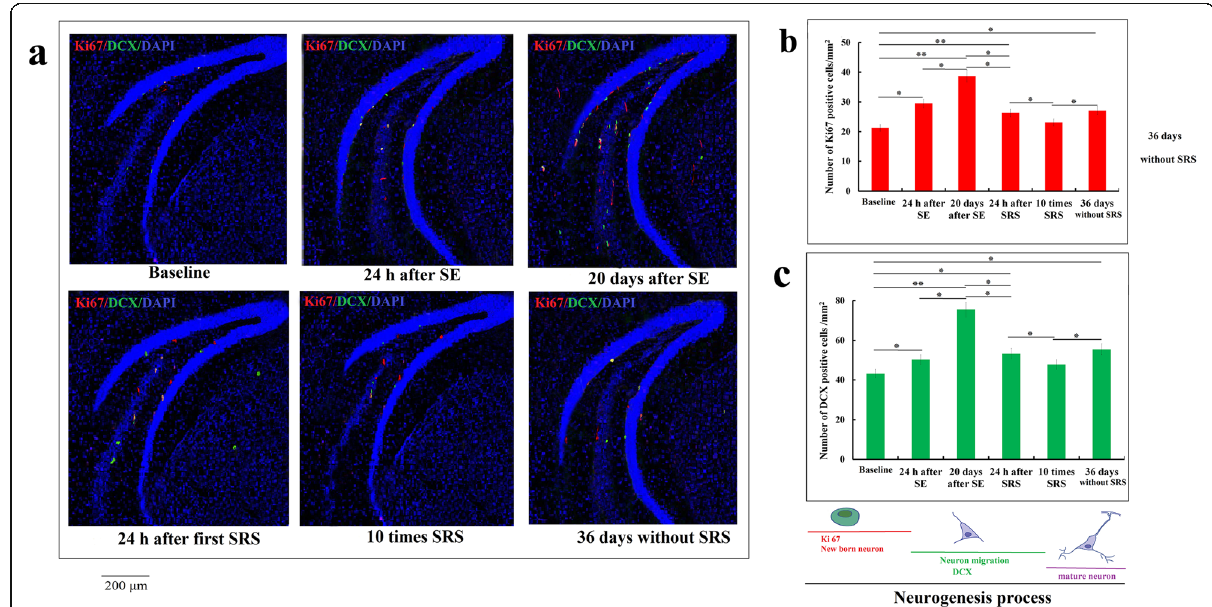
Fig. 2 Quantification of Ki67- and DCX-positive cells by immunohistochemical analysis. a Immunohistochemical staining of Ki67- and DCX- positive cells in CA3 and DG regions of the hippocampus. Scale bar represents 200 μ m. b and c Quantification of Ki67- and DCX-positive cells. The Ki67- and DCX-positive cells increased during the latent phase but significantly reduced after occurrence of SRS. The non-epileptic rats did not show significant increase in comparison to control (baseline). Data are presented as mean ± SEM.* P < 0.05 and ** P <